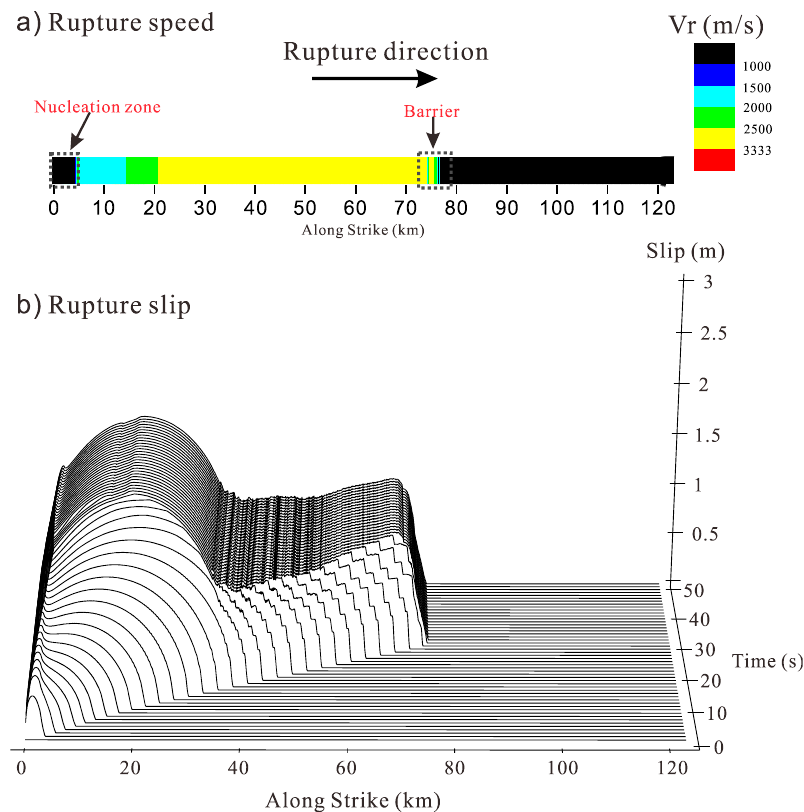
Figure 6. ( a ) Distribution diagram of the rupture speed of the fault surface. ( b ) Distribution diagram of the slip along the interface over time.